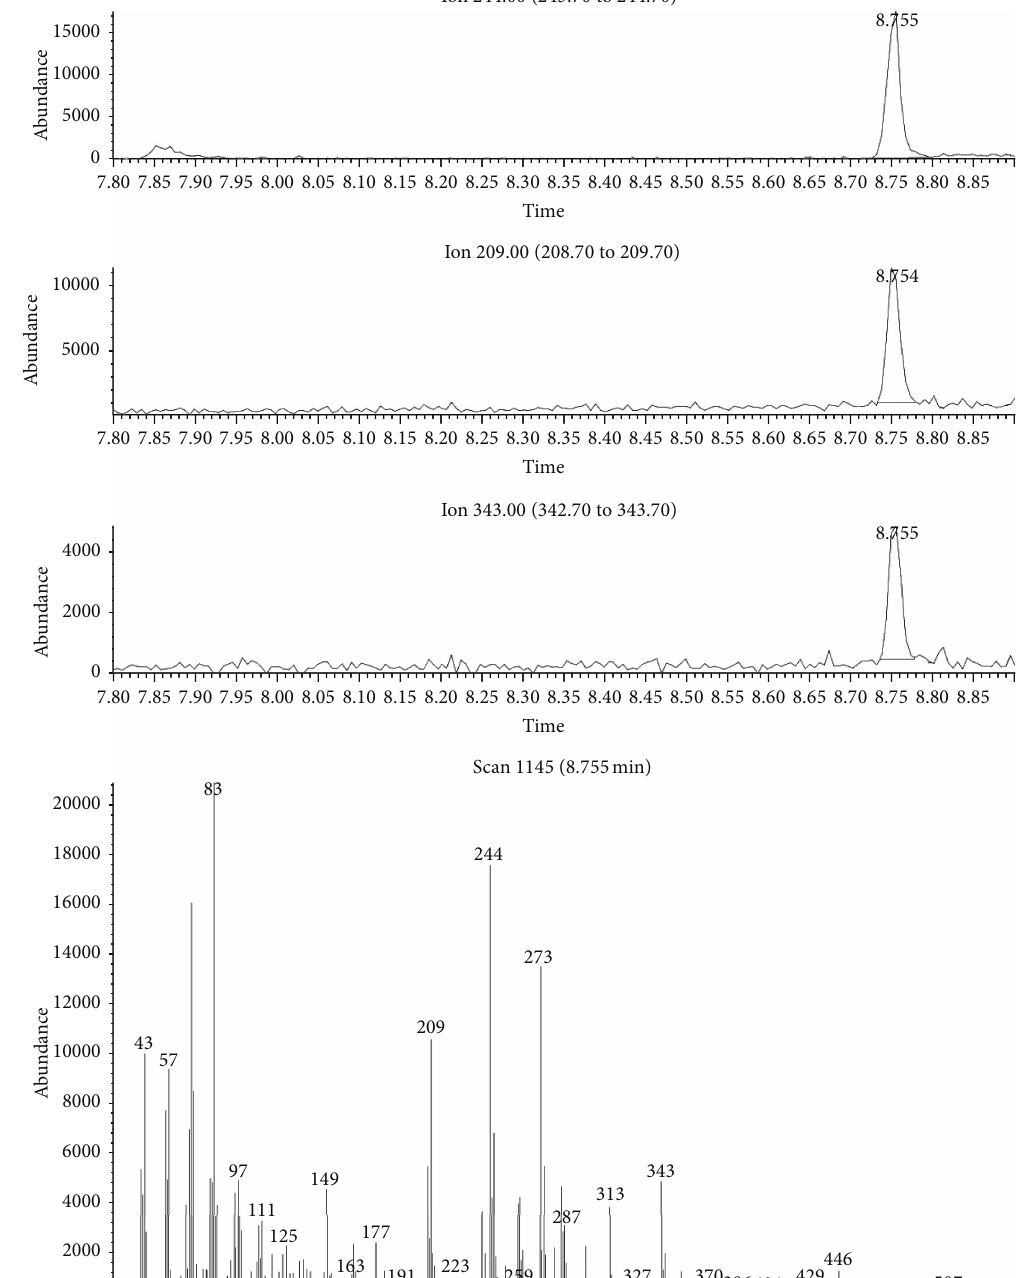
Figure 3: Full scan mode chromatogram and mass spectra obtained from blood sample